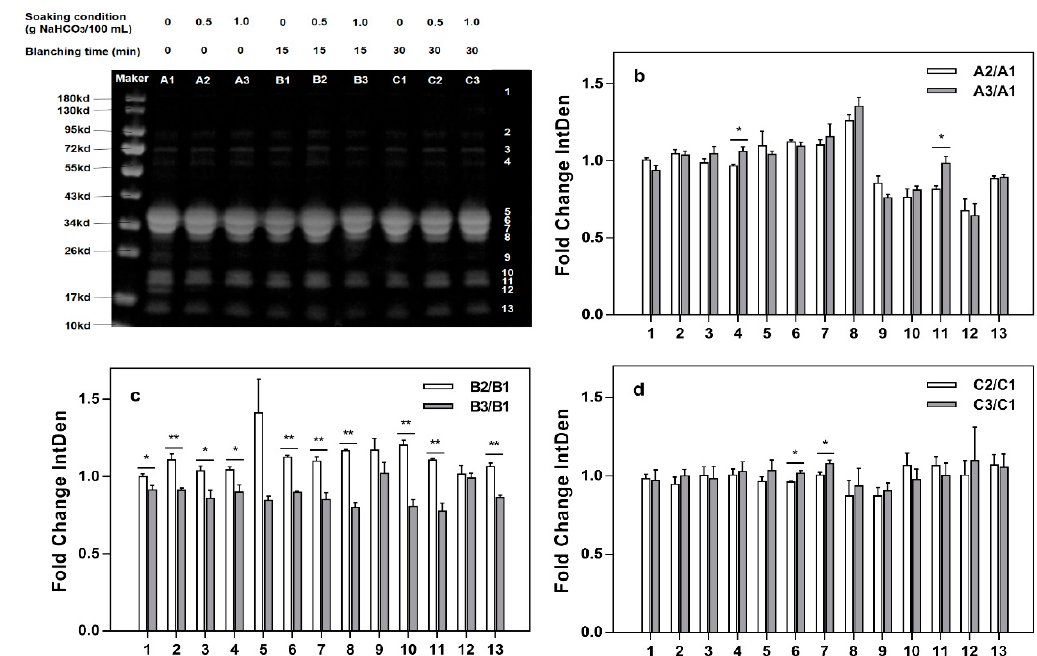
Figure 3. Influence of blanching on relative gray levels ( a ): sodium dodecyl sulfate polyacrylamide